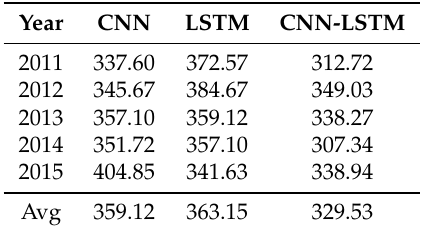
Table 2. Model performance of end-of-season yield prediction measured in root-mean-squared error (RMSE).